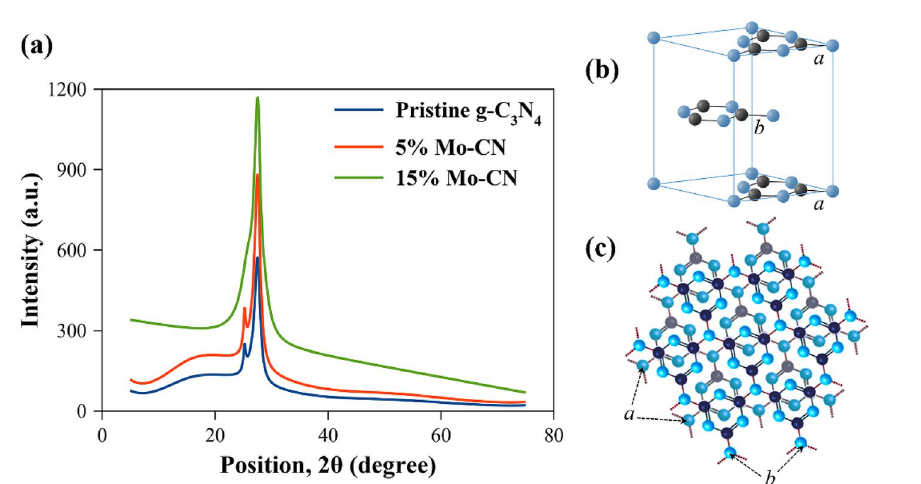
Figure 4. ( a ) XRD patterns of the as-prepared, pristine g-C 3 N 4 and Molybdenum impregnated g-C 3 N 4 samples. ( b ) The unit cell, formed by AB-stacking of planar graphitic layers shown in ( c